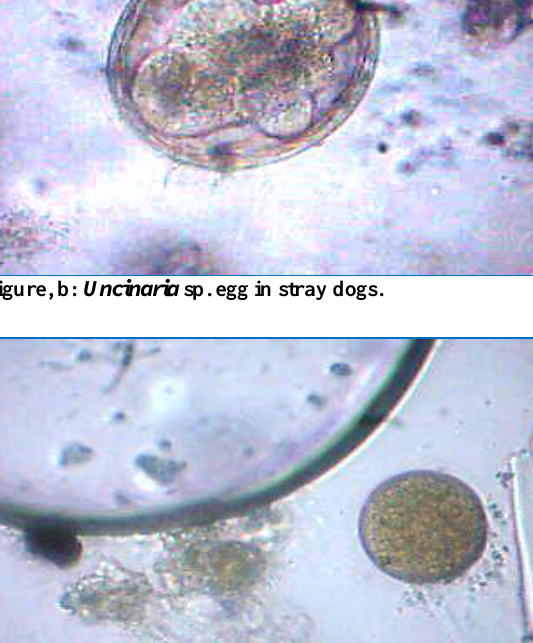
Figure, d: Trichuris vulpis egg in stray dogs.